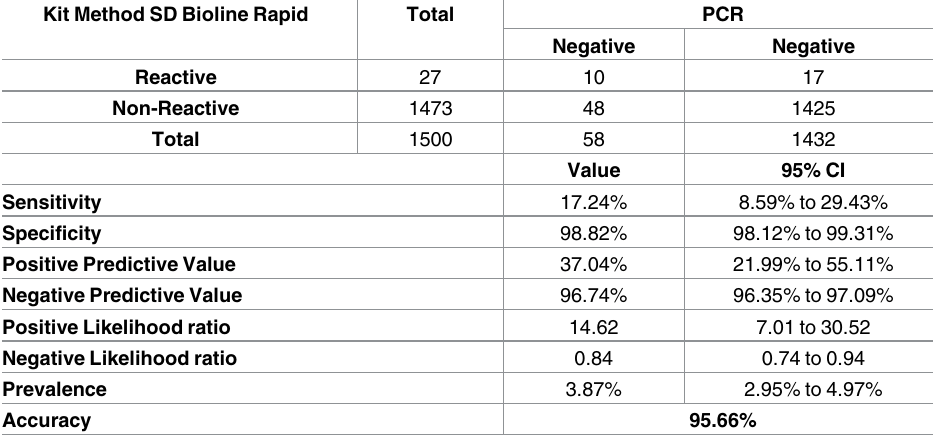
Table 1. Overall results of SD Bioline rapid kit (n =